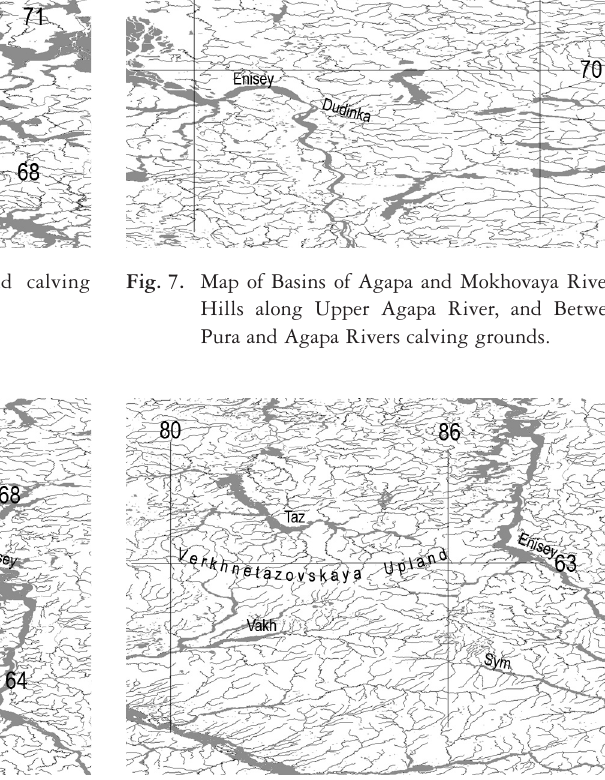
Fig. 9. Map of Verkhnetazovskaya Upland calving grounds.